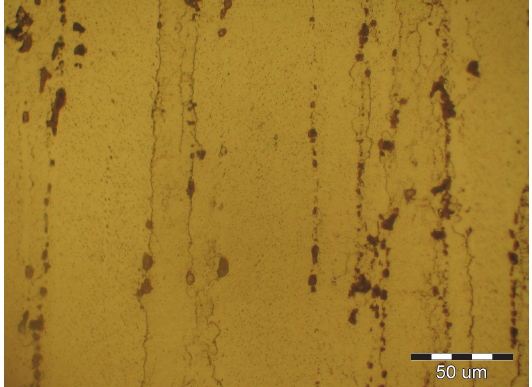
Figure 2: Microstructure of the AW-2017A-T4 aluminum